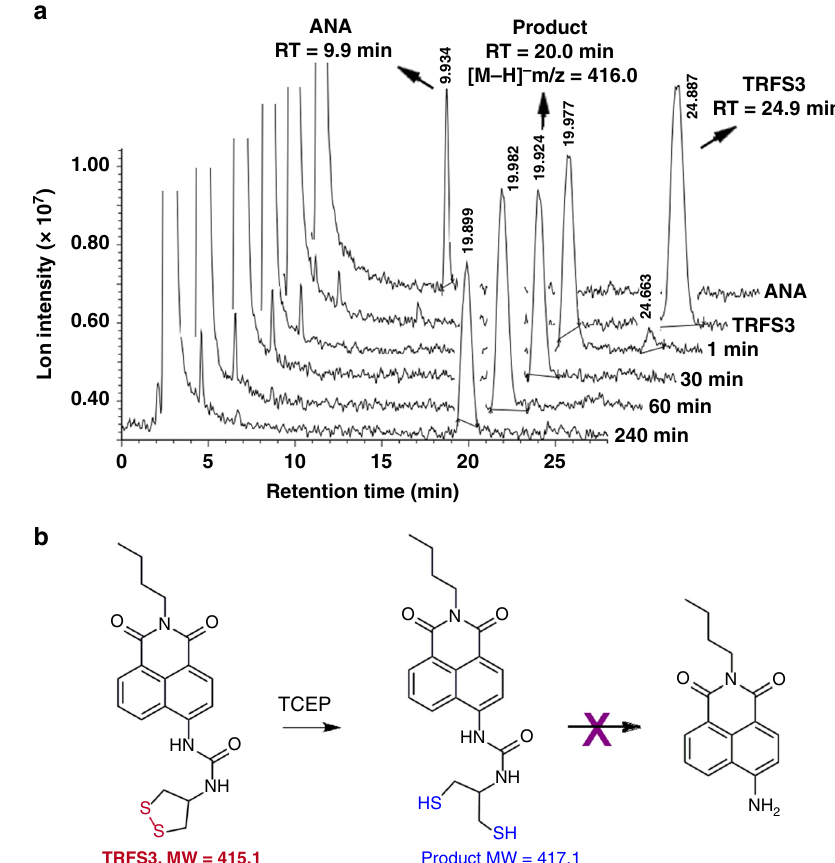
Fig. 4 Reaction details of TRFS3 and TCEP. a TRFS3 (20 μ M) was incubated with TCEP (1 mM) in TE buffer at 37 °C for 4 h. The reaction mixture was analyzed by HPLC-MS. b Proposed mechanism for the reduction of TRFS3 by TCEP. Source data are provided as a Source Data fi le.